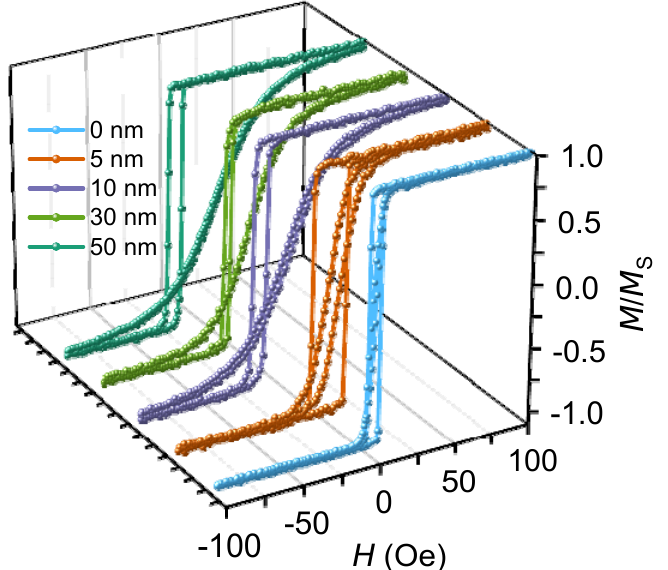
Figure 8. Hysteresis loops of NiFe (47 nm)/FeMn (t nm) thin-film structures with different FeMn layer thicknesses, along a sample easy axis and hard axis.